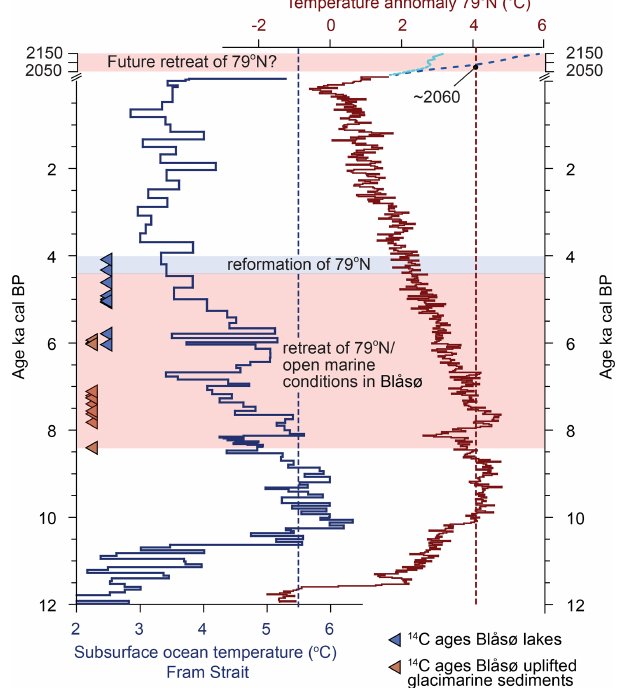
Figure 12. Marine conditions in Blåsø vs. atmospheric and ocean temperature. Ice shelf retreat (red shading) and reformation (blue shading) are constrained by 14 C ages (kacalBP) of shell sam- ples from uplifted glaciomarine sediments (brown triangles) and foraminiferal samples from LC12 and LC7 (light-blue triangles) in Blåsø. Subsurface ocean temperatures derived from planktic foraminiferal fauna assemblages (SST100) from core MSM5/5- 723-2 are shown using the blue curve (Werner et al., 2016). Summer temperature (JJA) at 79 ◦ N based on data-model outputs is shown using the red curve (Buizert et al., 2018). Also shown are the Repre- sentative Concentration Pathway (RCP) 2.6 (dotted light-blue line) and 8.5 (dashed dark-blue line) scenarios (Hofer et al., 2020). Ver- tical dashed lines denote mean ocean (blue) and atmospheric (red) temperatures for the Early Holocene ( ∼ 10–8ka). Under RCP8.5 (red shading), comparable Early Holocene atmospheric and ocean temperatures could occur by